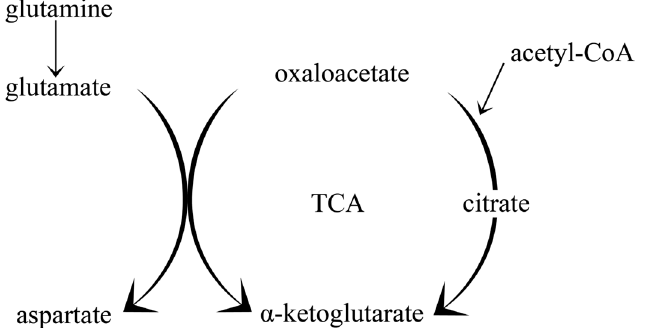
Figure 3. Amino acid metabolism in the brain. During ketosis, the amount of glutamate is increased. This may contribute to the increased flow through the TCA cycle.